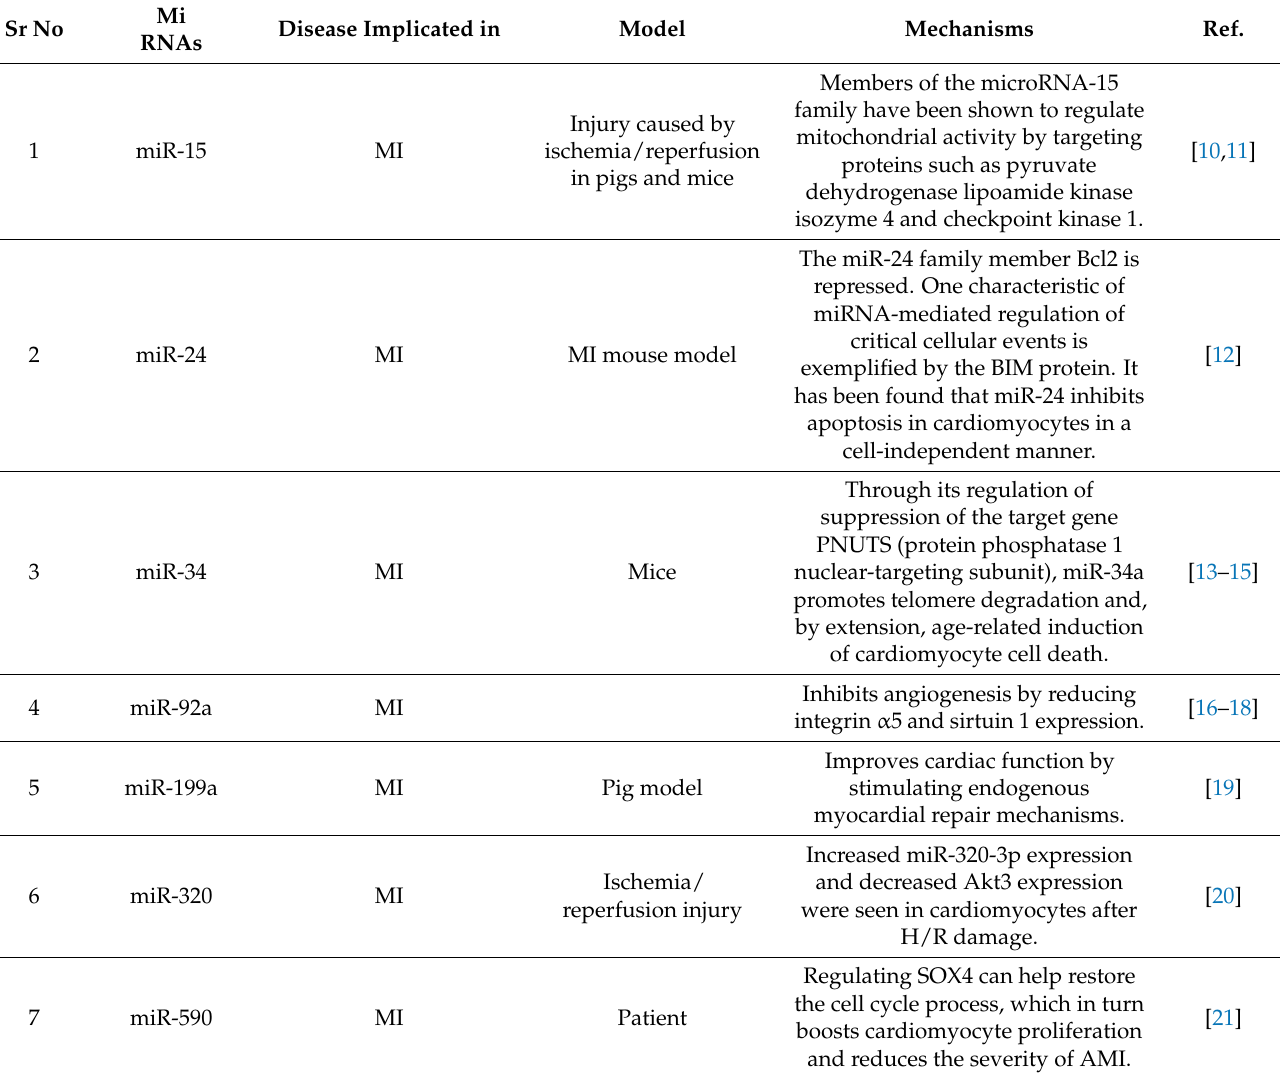
Table 1. Illustrations of Some of the Most Important microRNAs in the